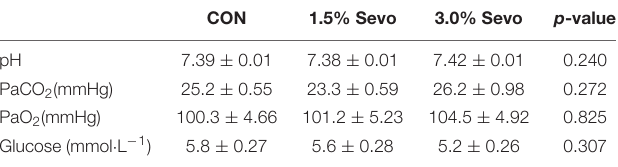
TABLE 2 | Arterial blood analysis of adult